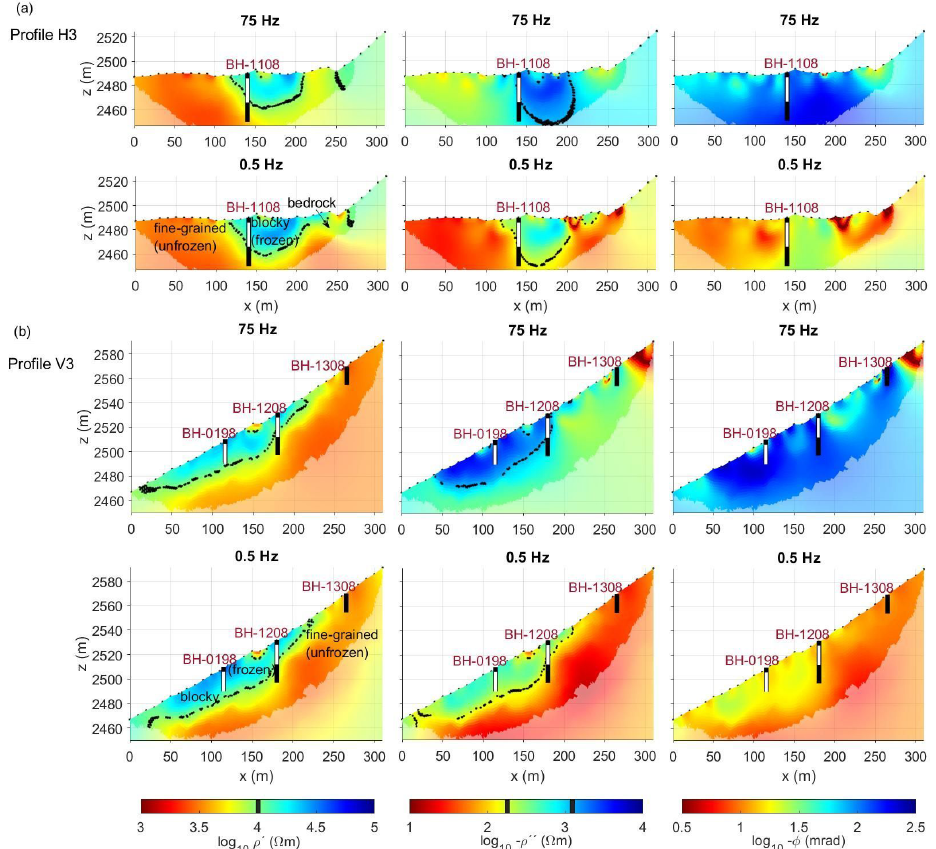
Figure 6. Complex resistivity inversion results in terms of real and imaginary components and phase at 75 and 0.5Hz for profiles (a) H3 and (b) V3. Our interpretation of frozen and unfrozen parts of the talus slope is indicated by the dashed line, corresponding to values of ρ (cid:48) = 10000 (cid:127) m, ρ (cid:48)(cid:48) = 160 (cid:127) m (at 0.5Hz) and 1260 (cid:127) m (at 75Hz). The boreholes BH-0198, BH1108, BH-1208 and BH-1308 indicate the thaw depth, permafrost body and permafrost base at the date of the measurement.